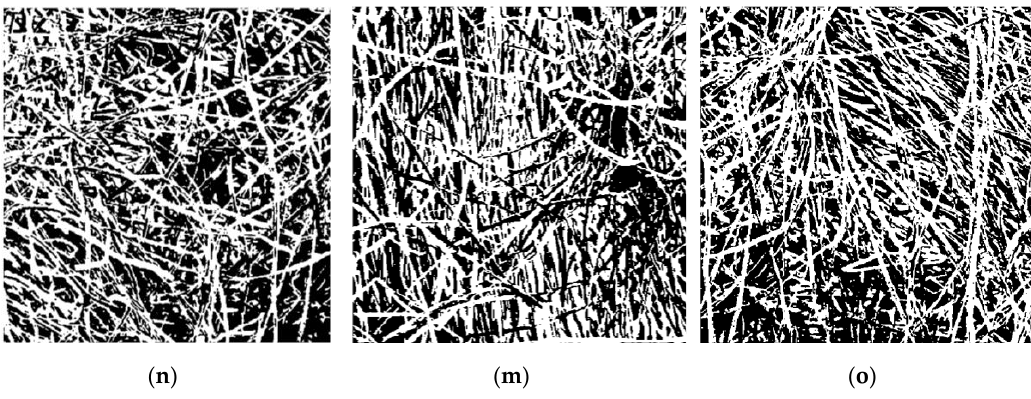
Figure A3. ( a ) Poplar seed fiber of 25% ( b ) Poplar seed fiber of 35% ( c ) Poplar seed fiber of 45%. ( d ) Poplar seed fiber of 55% ( e ) Poplar seed fiber of 65% ( f ) Density of 0.076 g/cm 3 ( g ) Density of 0.102 g/cm 3 ( h ) Density of 0.127 g/cm 3 ( i ) Density of 0.153 g/cm 3 ( j ) Density of 0.178 g/cm 3 (k) Thickness of 10 mm ( l ) Thickness of 15 mm ( m ) Thickness of 20 mm ( n ) Thickness of 25 mm ( o ) Thickness of 30 mm